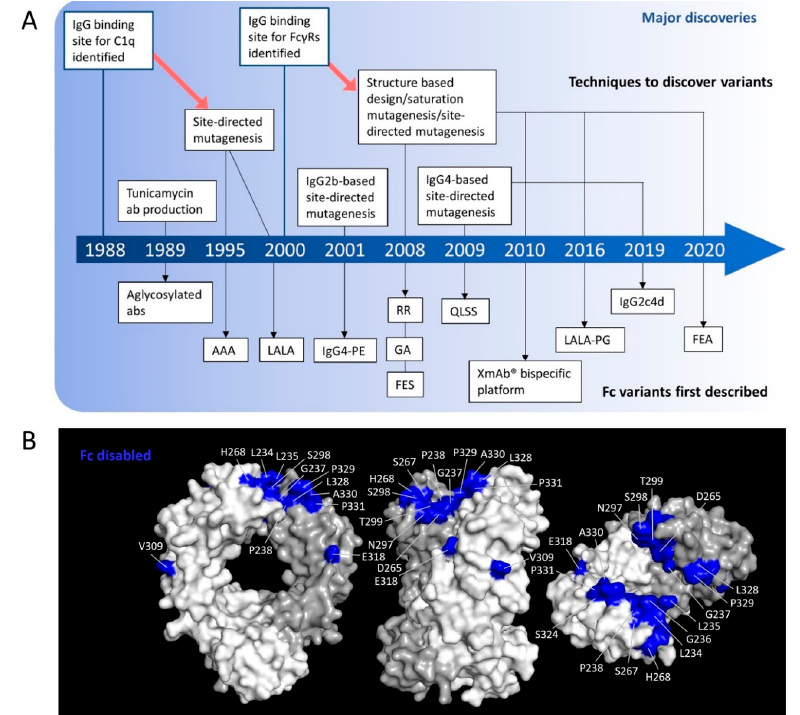
Figure 4. Fc modifications which reduce antibody effector function and/or Fc γ R binding. ( A ) Timeline of events detailing major discoveries, techniques used to discover variants that have a silenced Fc